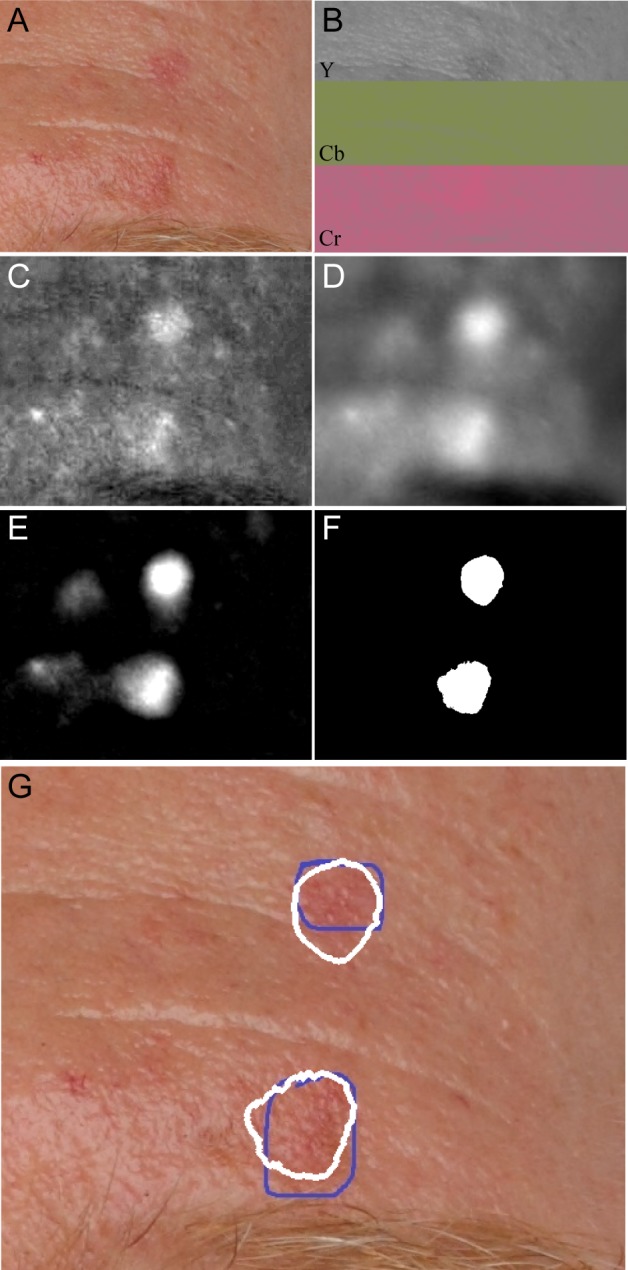
Overview of analysis steps in automated actinic keratosis detection, as applied to the dorsum of hand with the contrast adjusted for visualization.A) Input image. B) YCbCr transform of input image. C) Mean of Cb and Cr channels shows distinct hotspots for erythema. D) Guided filtering to remove unneeded texture. E) Distinct peaks extracted by morphological analysis. F) Hysteresis thresholding to identify erythematic areas. G) Boundaries of automatically detected lesions (white) compared with the dermatologist’s annotations (blue).